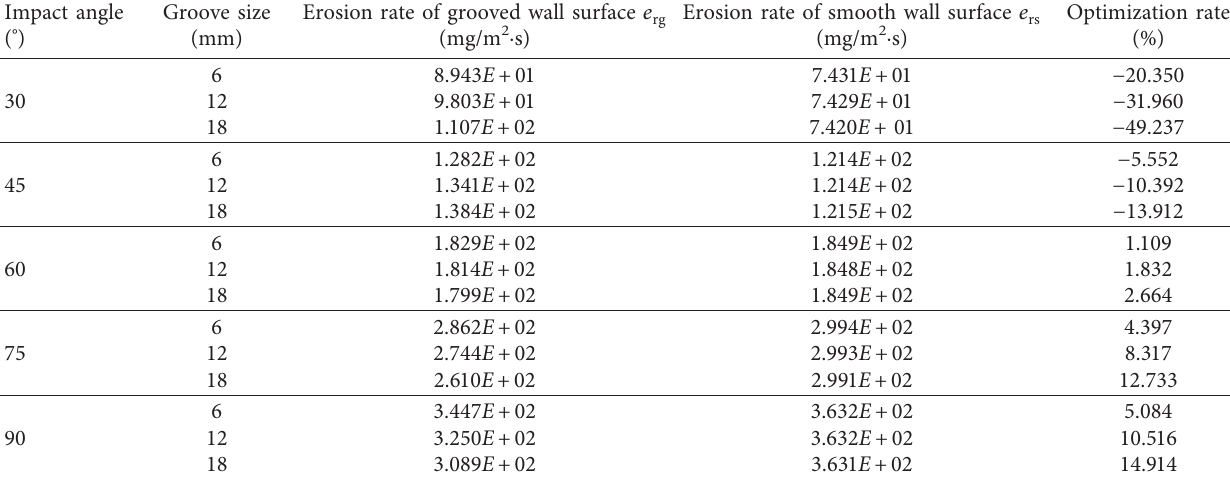
Table 2: Erosion rates of grooved and smooth wall surfaces under different groove sizes and impact angles.